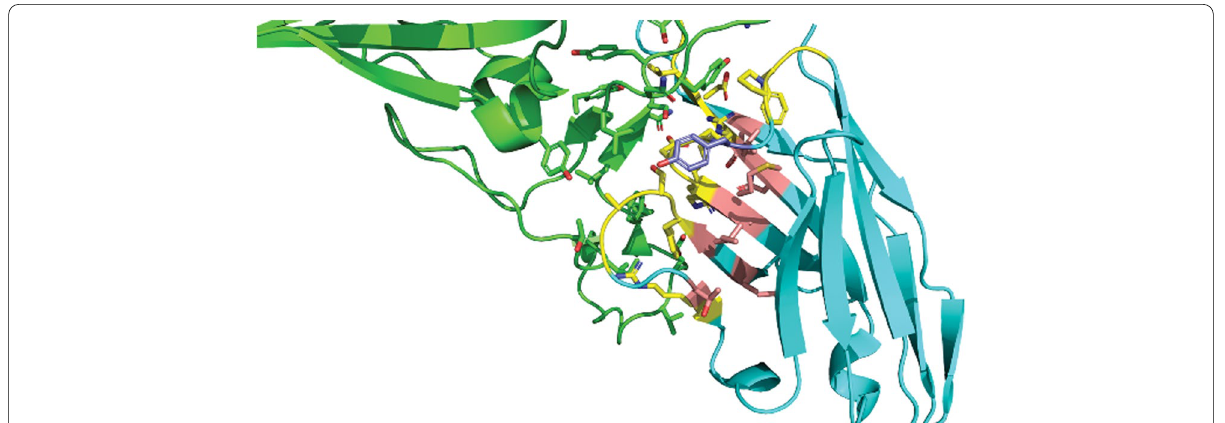
Fig. 7 A complex of a Nb and SARS-CoV-2 receptor-binding domain (RBD) (PDB ID: 7KGJ). The side chains of all residues that participated in the interaction are shown. RBD is green, and Nb sb45 is cyan. Residues of the Nb interacting with the antigen are yellow. Residues in the conserved CDR position are light pink. Residues in the conserved CDR position interacting with antigen are purple